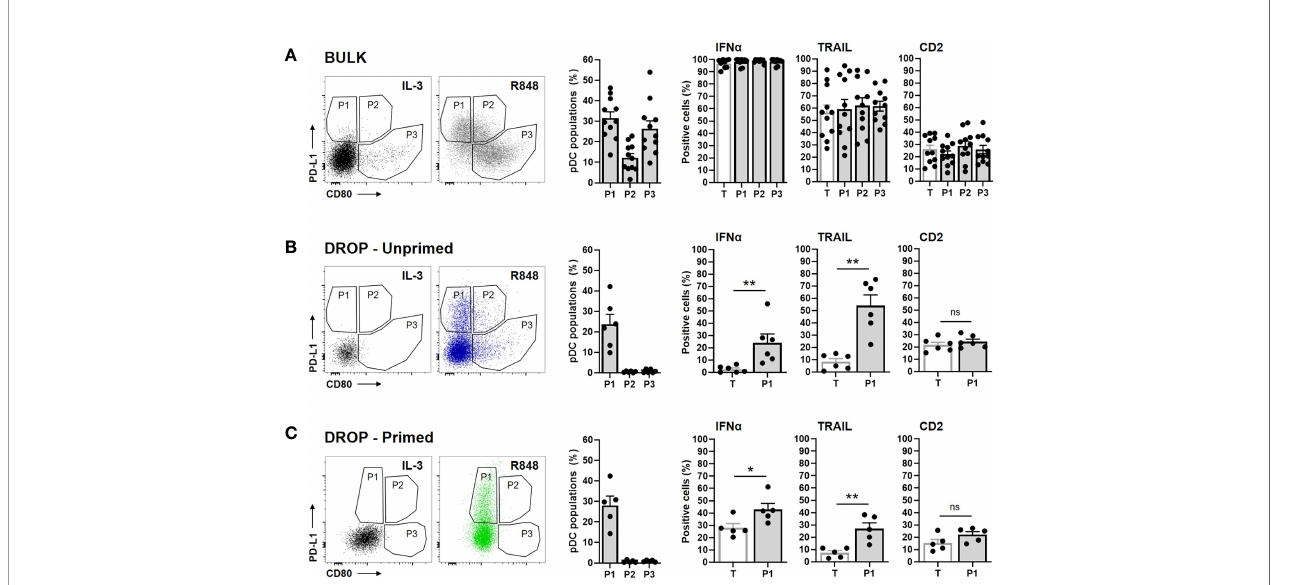
FIGURE 3 | PD-L1+/CD80- subsets are specialized IFN a producers and express high levels of TRAIL. Freshly isolated pDCs were either primed or left unprimed, coated with IFN a Catch Reagent, and activated in bulk or droplets as described before. The pDCs were activated with 5 or 50 m g/mL R848, for bulk and droplet conditions respectively, for 18h. Next, pDCs were stained for viability, IFN a secretion, surface marker expression of CD80, PD-L1, TRAIL, CD2, granzyme B and analyzed via fl ow cytometry. (A) Based on the expression of PD-L1 and CD80, 3 populations were de fi ned for the bulk activated pDCs. IL-3 stimulated pDCs served as a control for gating. The fi rst histogram represents the percentages of the 3 populations. Other histograms represent the percentages of positive cells for the indicated markers, for the total viable pDCs (T) and the 3 populations (P1, P2, P3). (B) Data as in panel (A) , for unprimed single-activated pDCs. Expression of markers is only plotted for T and P1, because of the low percentages of P2 and P3 present in total. (C) Data as in (B) , for primed single-activated pDCs. Bars represent mean percentages; error bars indicate SEM; BULK n = 11; DROP-Unprimed n = 6; DROP-Primed n = 5. Mann – Whitney test *p < 0.05, **p < 0.01. ns, non-signi fi